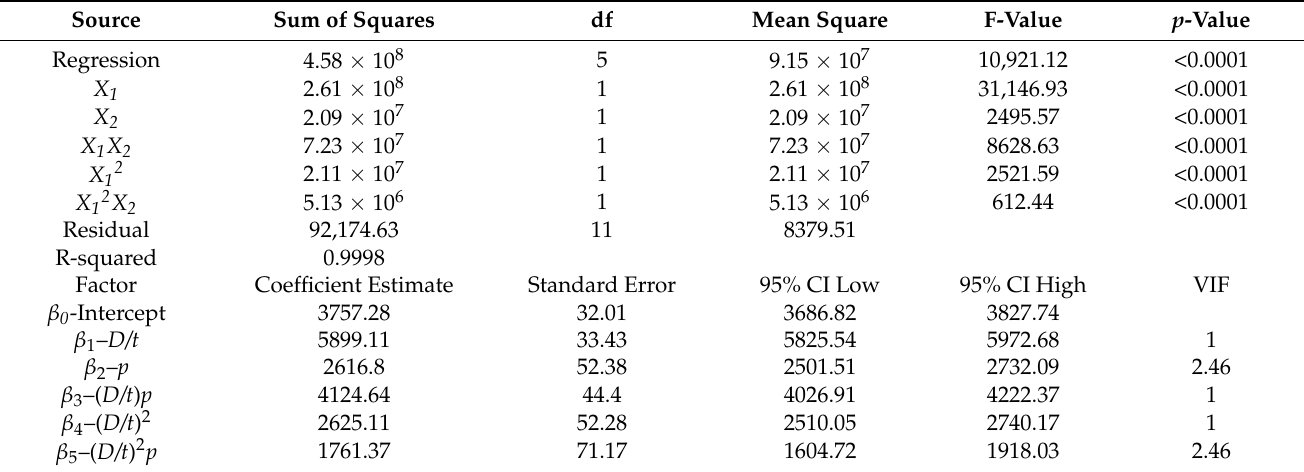
Table A2. ANOVA results of the reduction-cubic